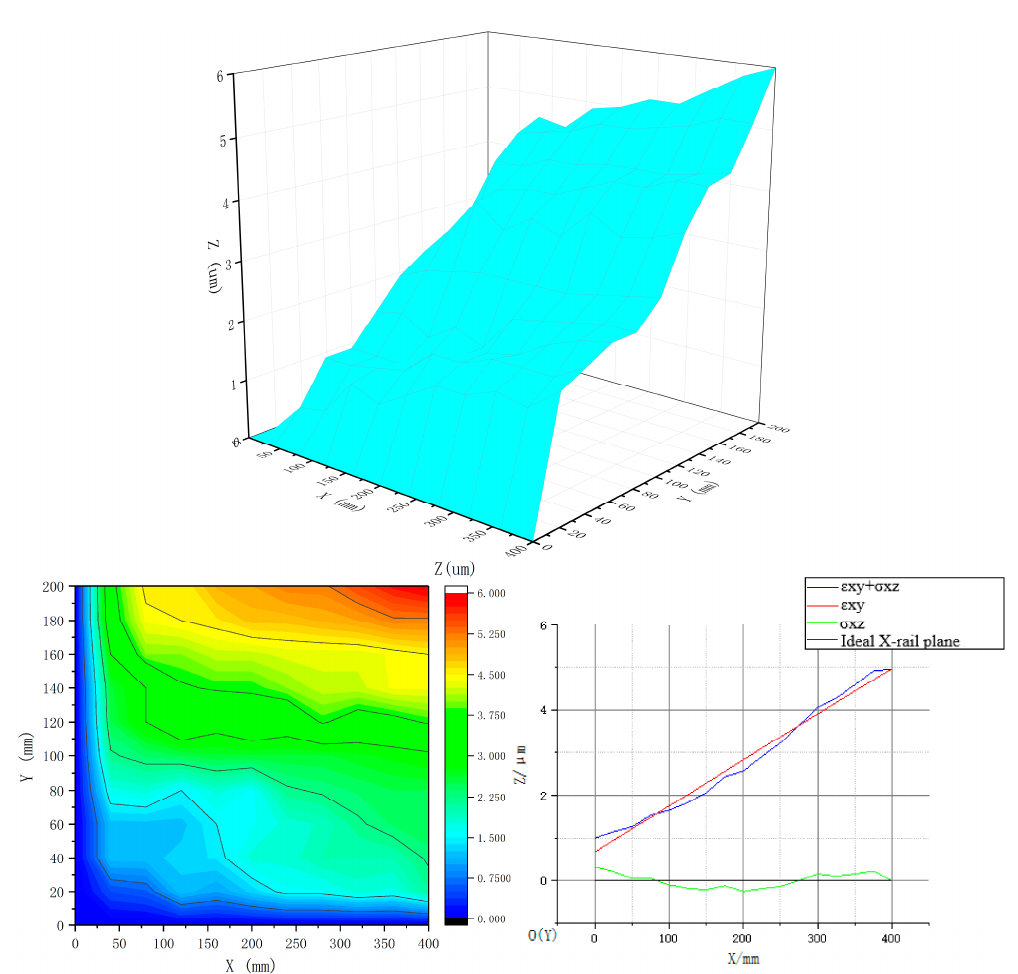
Figure 7. Geometric error measuring and decoupling on the XOZ plane of the X-axis. According to the figure above,